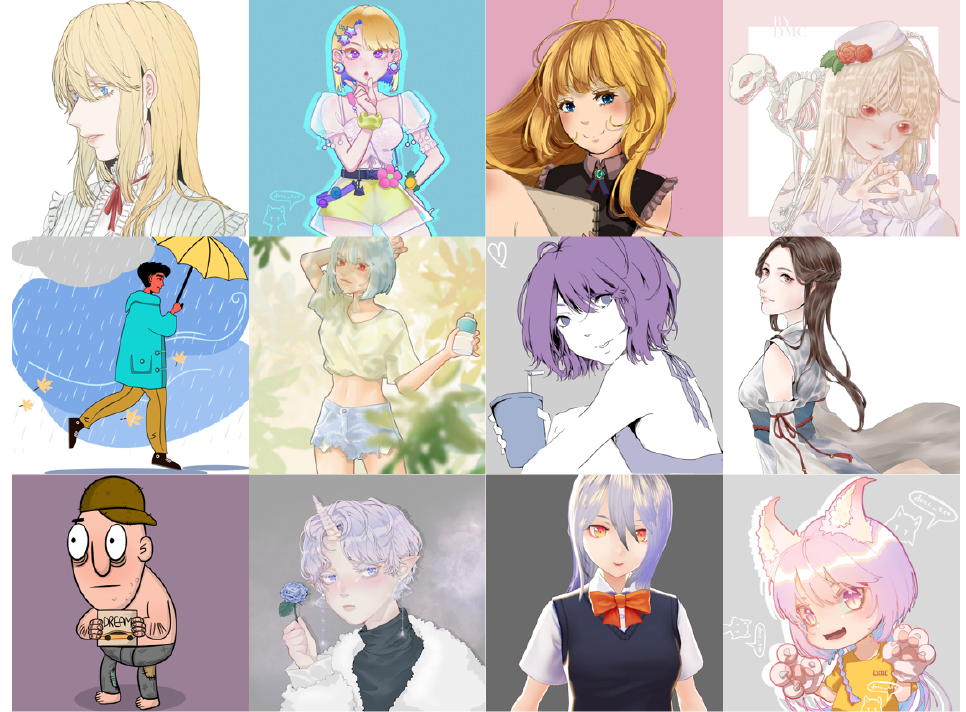
Figure 18. Example images from the AnimeCharacter12 dataset. HR is 1024 × 1024, LR are 128 × 128, 256 × 256, 512 × 512. The images are adopted from